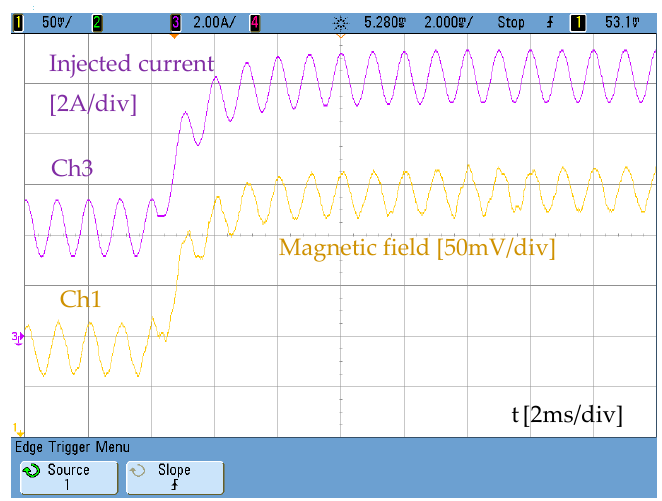
Figure 12. Measurement of the magnetic field generated when a DC current step is applied. Trace 1-yellow (12 V/Tesla), trace 3-purple: current through the AC winding. Sensors 2019 , 19 , x FOR PEER REVIEW